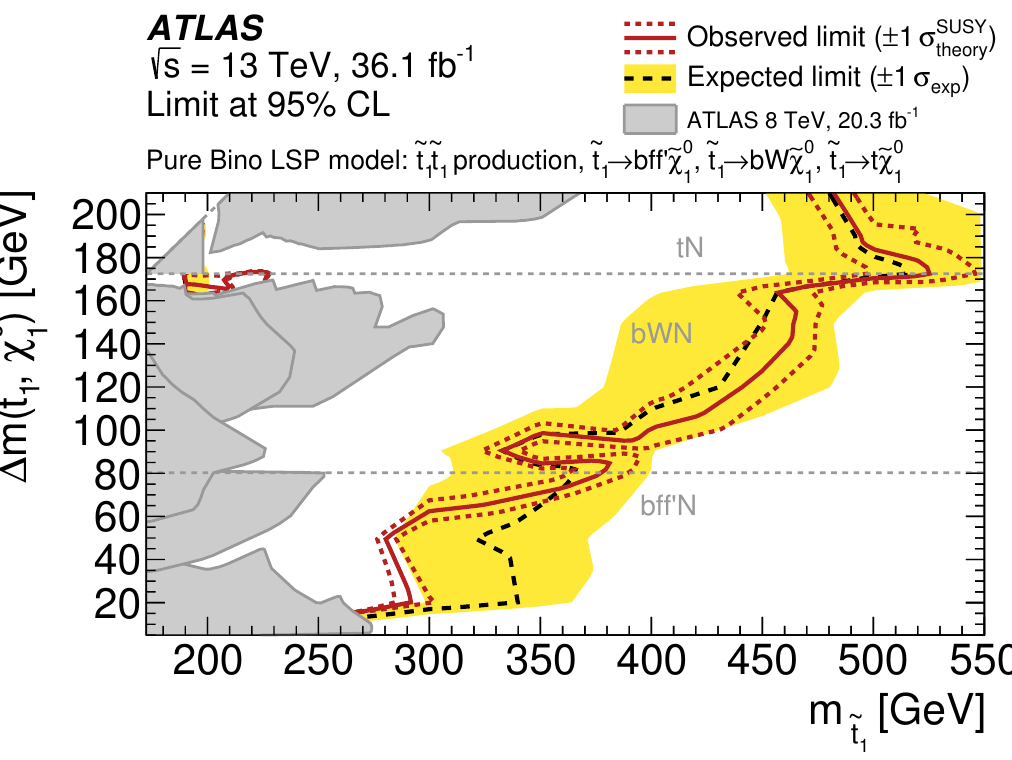
Figure 21 . Expected (black dashed) and observed (red solid) 95% excluded regions in the plane of (cid:1) m (~ t ; ~ (cid:31) 0 1 ) versus m ~ for direct stop pair production assuming either ~ t 1 t 1 ~ t bff 0 ~ (cid:31) 0 1 decay with a branching ratio of 100%. The excluded regions from previous publica- 1 ! tions [37, 168] are shown with the grey shaded